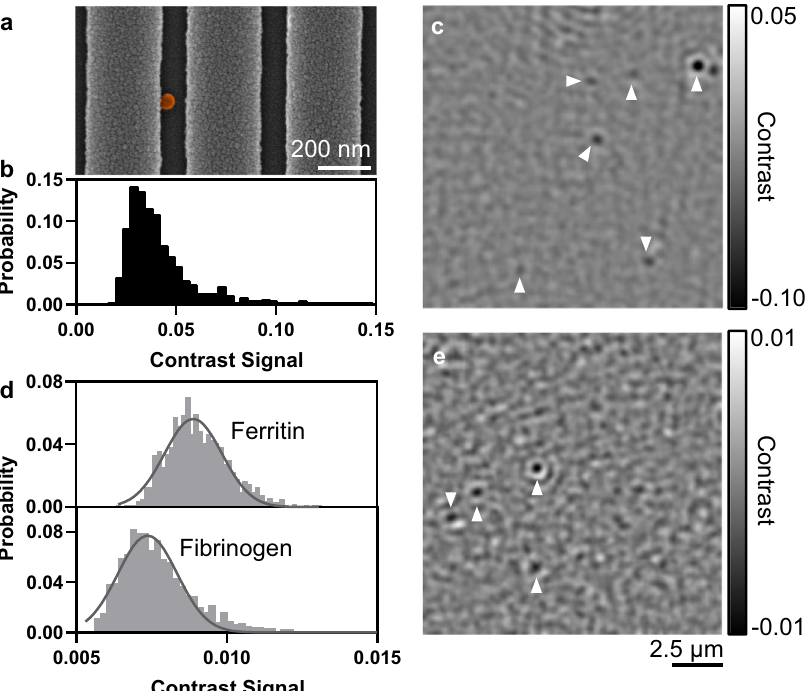
Fig. 5 Application of PRISM to detect individual viruses and protein molecules. a False-colored SEM image of an inactivated SARS-CoV-2 virion on the PC substrate. b Contrast histogram obtained from over 500 individual virus signals. c , e Representative interferometric image with additional identi fi ers (white arrows) for coronaviruses and ferritin molecules within the fi eld-of-view. d Distribution of contrast signal from individual ferritin (440 kDa, contrast: 0.88 ± 0.09%) and fi brinogen (340 kDa, contrast: 0.77 ± 0.09%). n > 1000 for each protein